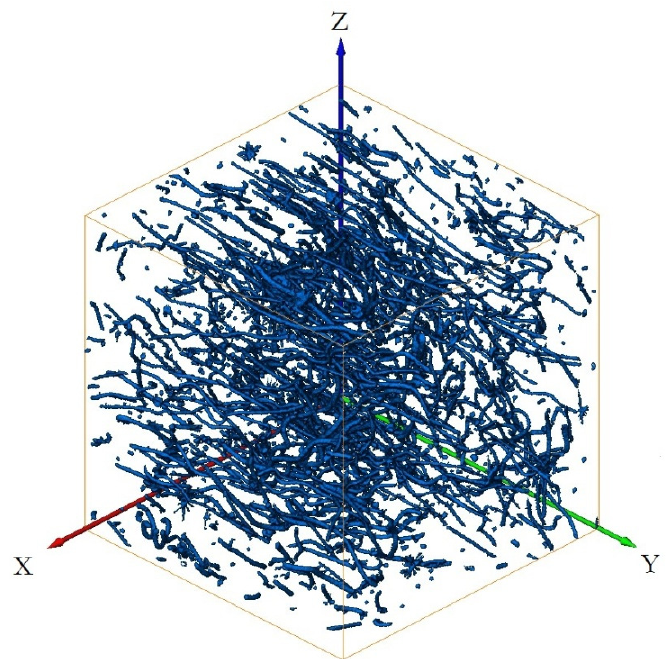
Figure 14. The second reconstruction of polyester short fibers image by Avizo software.